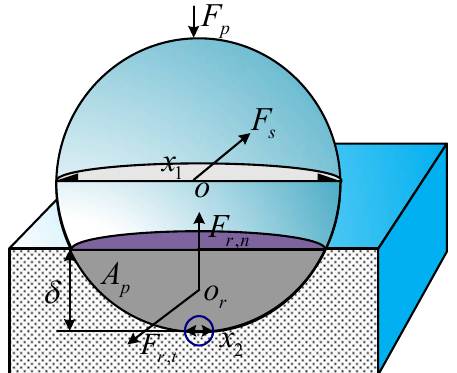
Figure 3. Theoretical calculation model of effective indentation depth of abrasive particles.